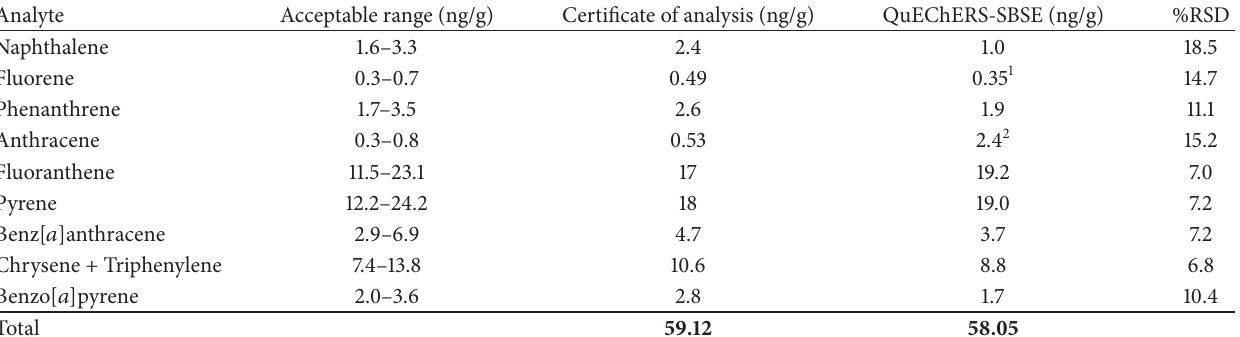
Table 4: Analysis on SRM mussel tissue.